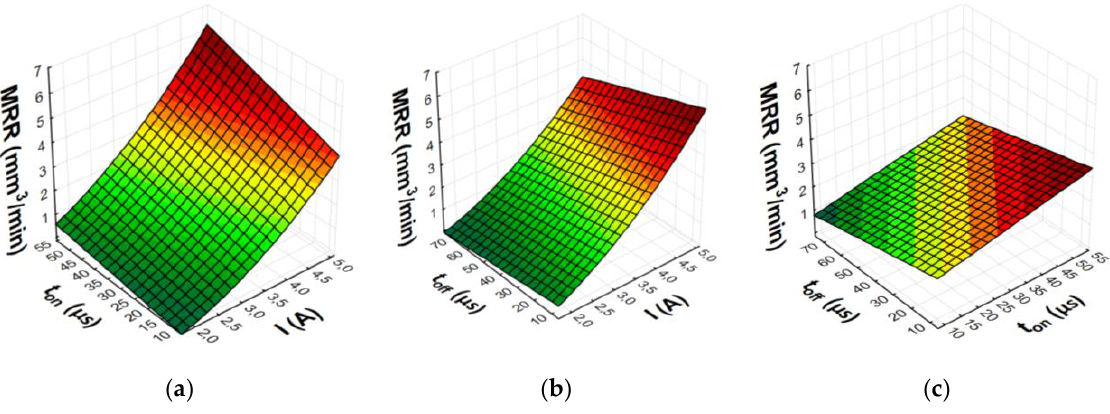
Figure 8. Graphical representation of regression equation for MRR of S-180 graphite electrode: ( a ) t off = 40.5 µs; ( b ) t on = 31.5 µs; ( c ) I = 3.4 A.